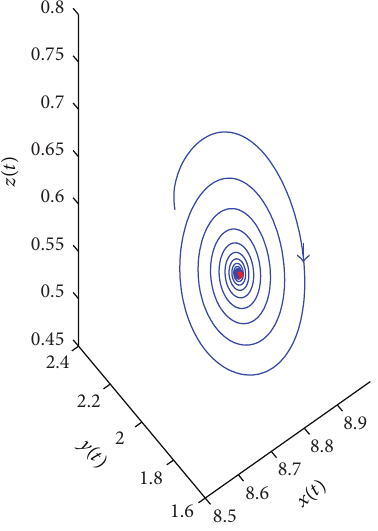
Figure 2: The CTL-present infection equilibrium 𝐸 2 of system (3) is locally asymptotically stable when 𝑅 1 = 1.45 > 1 and 𝜏 = 0.2 < 𝜏 .